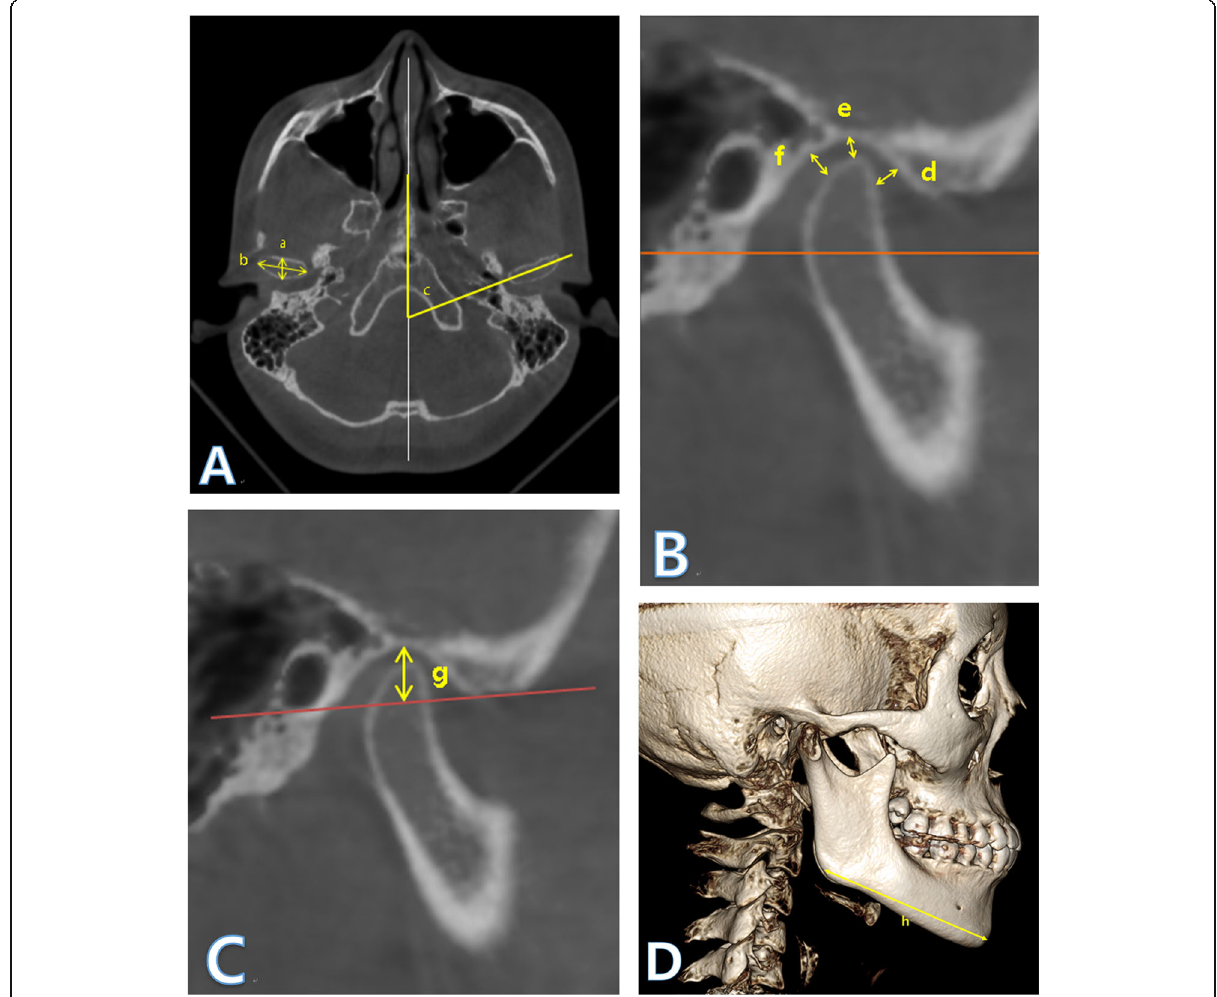
Fig. 1 Measuring method on the In Vivo 5 dental software. (a) Anteroposterior width, (b) mediolateral width, and (c) condyle axis angle ( A ). (d) Anterior joint space, (e):superior joint space, and (f) posterior joint space ( B ). (g) Fossa depth ( C ). (h) Mandibular body size ( D